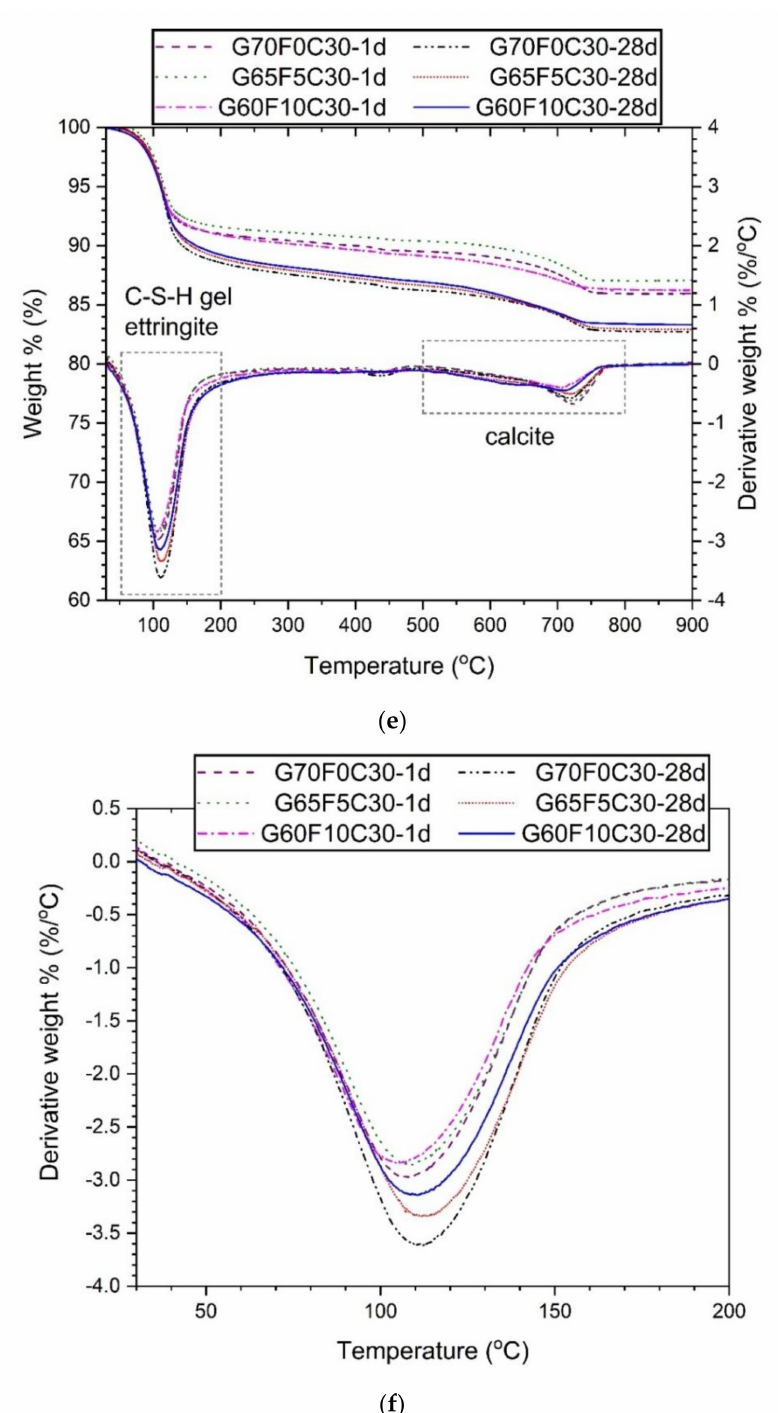
Figure 8. Thermal analysis (TG/DTG) at 1 d and 28 d, ( a ) 10% CSAe samples, ( b ) 50–200 ◦ C tempera- ture range enlargement of 10% CSAe samples, ( c ) 20% CSAe sampless, ( d ) 50–200 ◦ C temperature range enlargement of 20% CSAe samples, ( e ) 30% CSAe samples, ( f ) 50–200 ◦ C temperature range enlargement of 30% CSAe